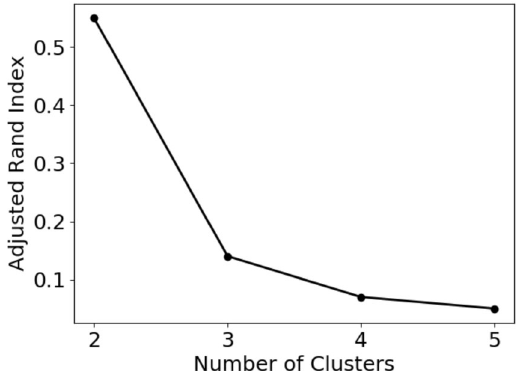
Fig. 2 Adjusted Rand Index as a function of the number of clusters. When more than two clusters are used to initialize spectral clustering, the steep drop in ARI corresponds to a decrease in precision. As such, when more than two clusters are speci fi ed, the spectral clustering algorithm is forced to fi nd clusters, which are not correlated with damage mechanisms. This drop occurs in all experiments and is corroborated by results shown in Fig.